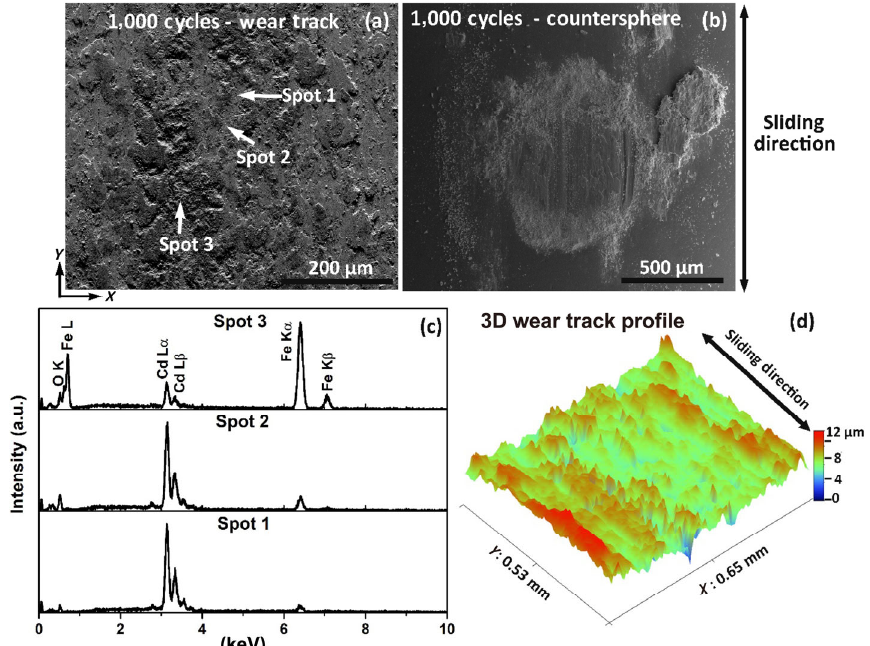
Fig. 10 (a) Wear track morphology with dominant Fe substrate, (b) countersphere imaging showing wear scar at the contact region, (c) EDS spot analysis of wear track, and (d) 3D surface profile at 1,500